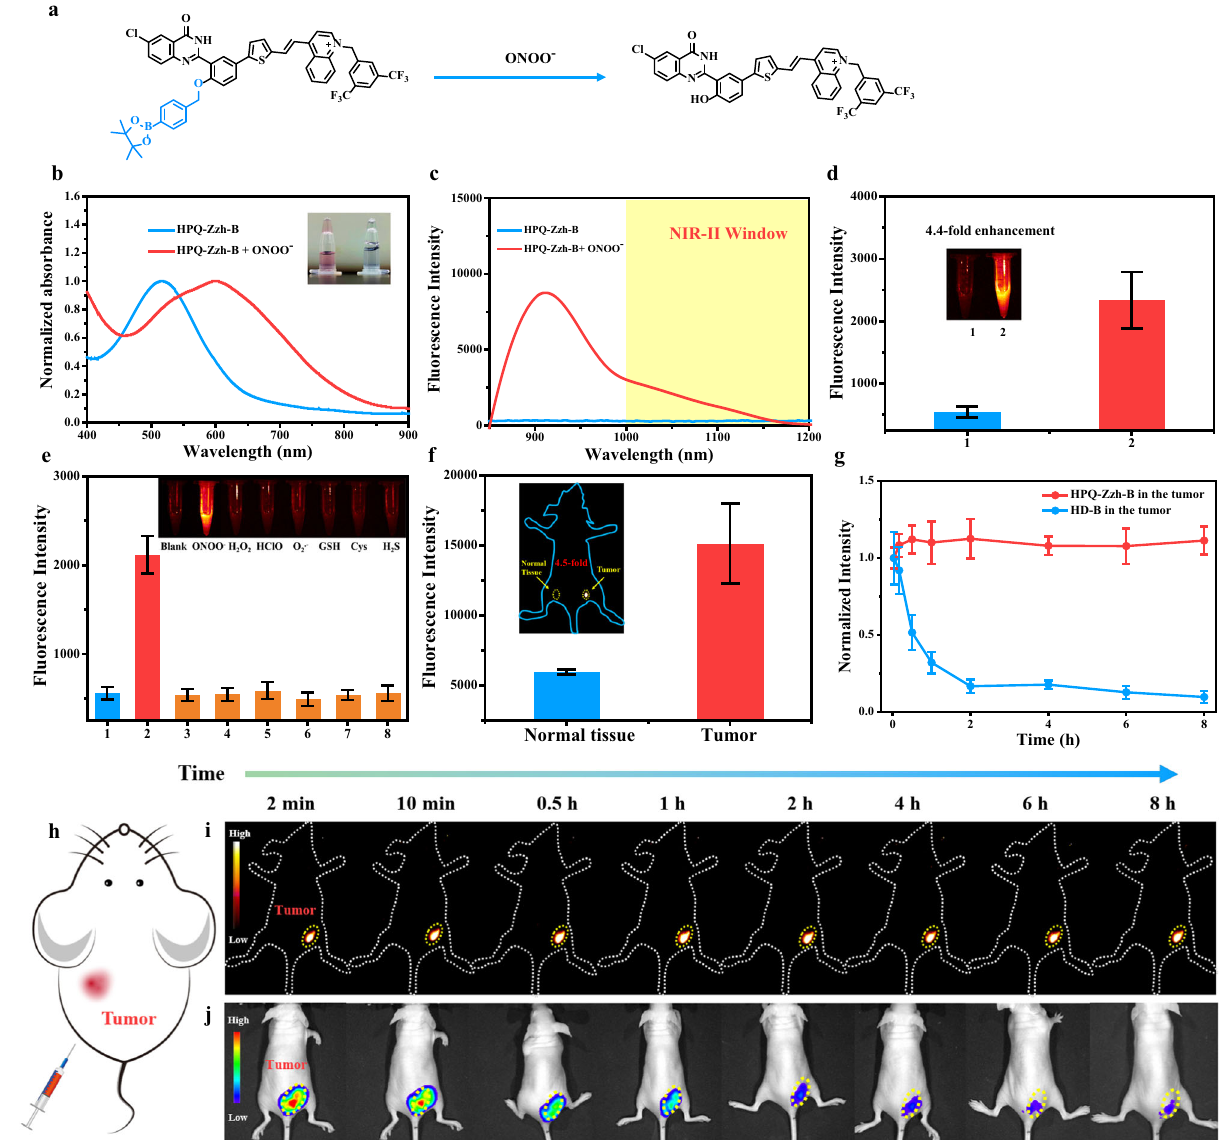
Fig. 5 | Spectroscopy experiments and in vivo anti-diffusion experiments of HPQ-Zzh-B. a Schematic diagram that HPQ-Zzh-B reacted with ONOO - . b Normalized absorbance of HPQ-Zzh-B and HPQ-Zzh-B with ONOO - in DPBS+1% Tween. c Fluorescence spectrum of 10 μ M HPQ-Zzh-B and 10 μ M HPQ-Zzh-B with 5 μ MONOO - inDPBS+1%Tween. d NIR-II fl uorescenceof10 μ M HPQ-Zzh-B (1)and 10 μ M HPQ-Zzh-B with 5 μ M ONOO - (2) in DPBS+1% Tween, respectively, the illustration showed their NIR-II fl uorescence, left: HPQ-Zzh-B , right: HPQ-LZ- B +ONOO-. Data were presented as mean±s.d. derived from n =3 independent biological samples. e NIR-II fl uorescenceof HPQ-Zzh-B (10 μ M) to various analytes (1. blank, 2. 5 μ M ONOO - , 3. 100 μ M H 2 O 2 , 4. 50 μ M HOCl, 5. 20 μ M O 2 .- , 6. 3mM GSH, 7. 100 μ M Cys, 8. 100 μ M H 2 S.) λ ex =808nm, collection channel: 1000 – 1700nm.Datawerepresentedasmean±s.d.derivedfrom n =3independent Supplementary Fig. 25, HPQ-Zzh-B exhibited high selectivity to ONOO - relative to other biological species, such as H 2 O 2 , HOCl, O 2 .- , GSH, Cys, and H 2 S. We opted to apply the probe to the image in the living body. After HPQ-Zzh-B reacted with ONOO- in vivo, its NIR-II fl uorescence displayed a 2.1-fold enhancement (Supplementary Fig. 26). These results indicated that HPQ-Zzh-B could be used as an ef fi cient NIR-II bioimaging probe for ONOO - detection. edly higher than that in normal tissues 40 , we investigated whether the